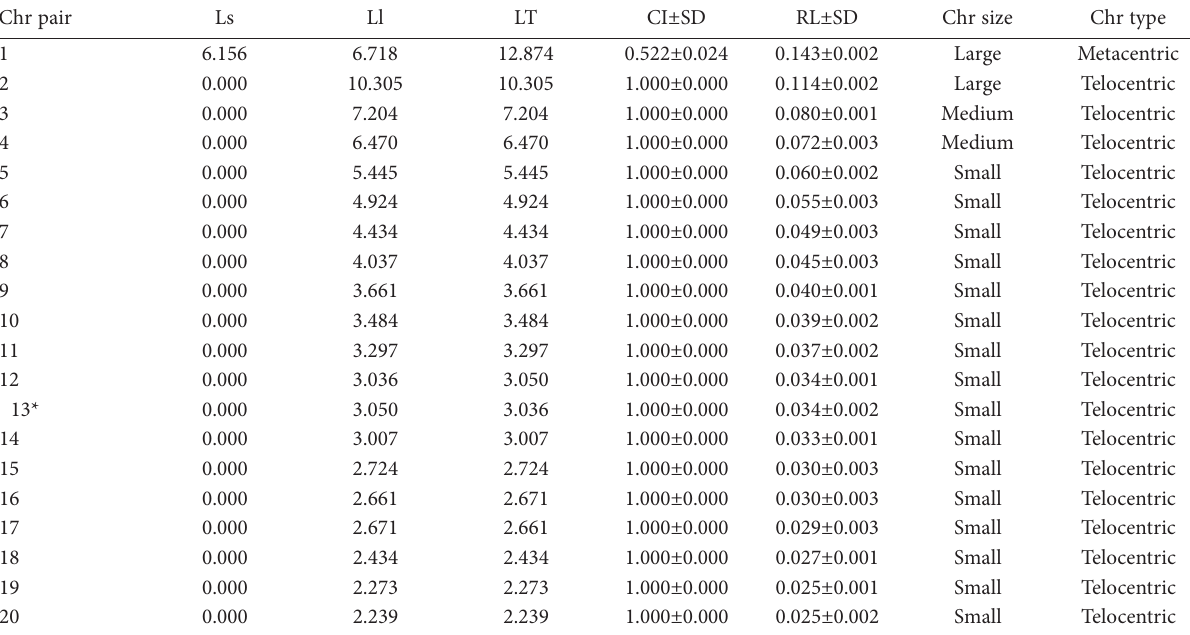
Table 1. Mean length of short arm chromosome (Ls), long arm chromosome (Ll), length of total chromosomes (LT), centromeric index (CI), relative length (RL) and standard deviation (SD) of CI and RL from 20 metaphases of male and female yellow-tailed leaf-toed gecko ( Dixonius hangseesom )